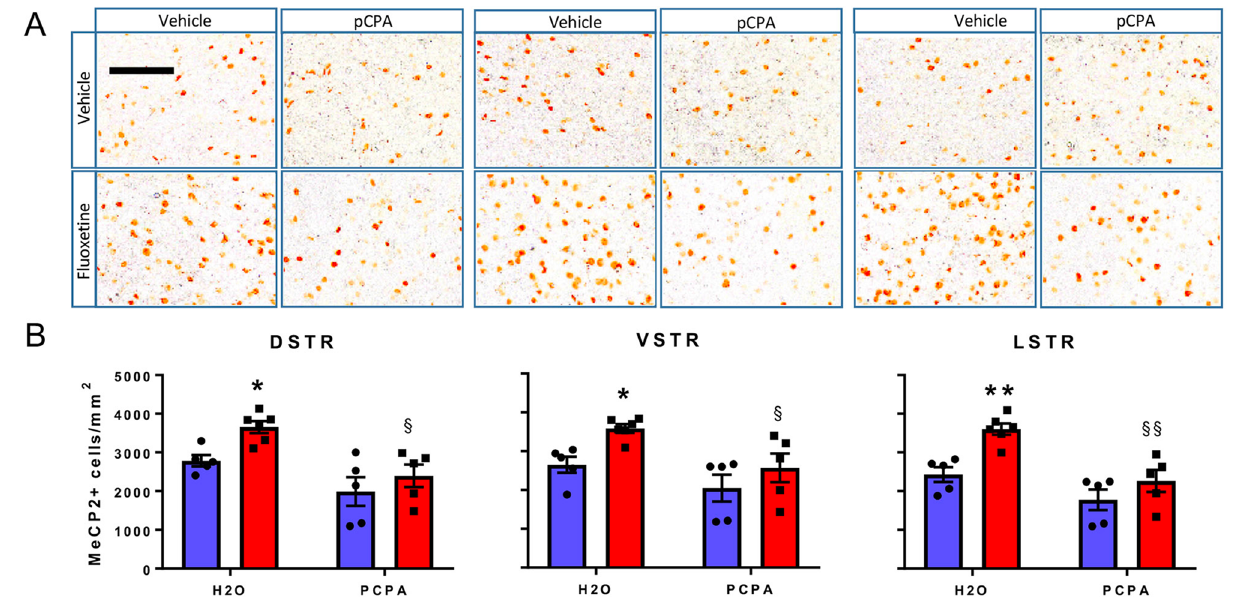
Figure 5. Reversal of FLX-induced rise of MeCP2 + cells by the 5-HT synthesis inhibitor pCPA in the DSTR, VSTR and LSTR. ( A ) Enlargements of the original pictures obtained by the VS120 microscope showing MeCP2 + cells (brown dots) in representative sections of the dorsal (DSTR), ventral (VSTR) and lateral (LSTR) striatum of Mecp2 HET mice treated with 10 mg/kg FLX or water (H 2 O) for 17 days plus PCPA from days 15 to 17. On day 18, mice were euthanised and their brain processed for MeCP2 immunohistochemistry. Scale bar, 100 µm. ( B ) Histograms, generated with the Prism software (version 7.02; https:// www. graph pad. com/ scien tific- softw are/ prism/), show the mean number (± SEM) of MeCP2 + cells (5–6 mice/group). Blue and red columns indicate treatment with vehicle and FLX, respectively. Black dots and squares represent individual data points. * P < 0.05 and ** P < 0.01 versus H 2 O–H 2 O; § P < 0.05; §§§ P < 0.001 versus H 2 O-FLX (Sidak’s test).